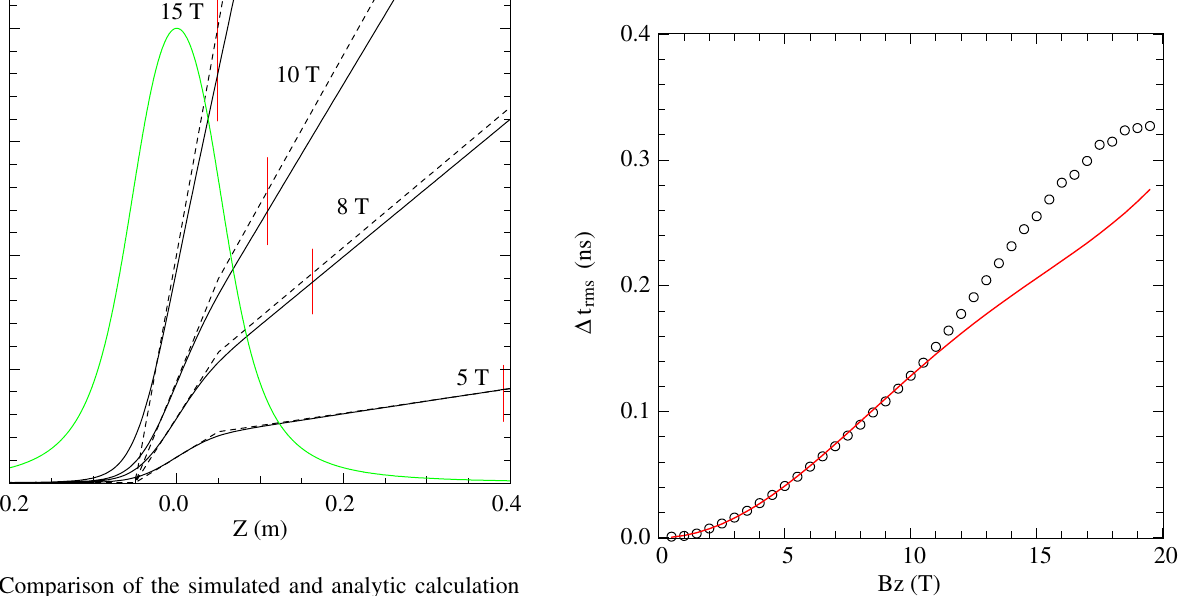
FIG. 3. Comparison of the simulated and analytic calculation of (cid:1) t rms for several different solenoid strengths. For each case, the solid line is from the simulation and the dashed line is from the analysis. The red vertical lines show the locations of the focal spots for the simulated cases. The green curve shows the longi- tudinal profile of the solenoid field, scaled vertically to fit the graph.